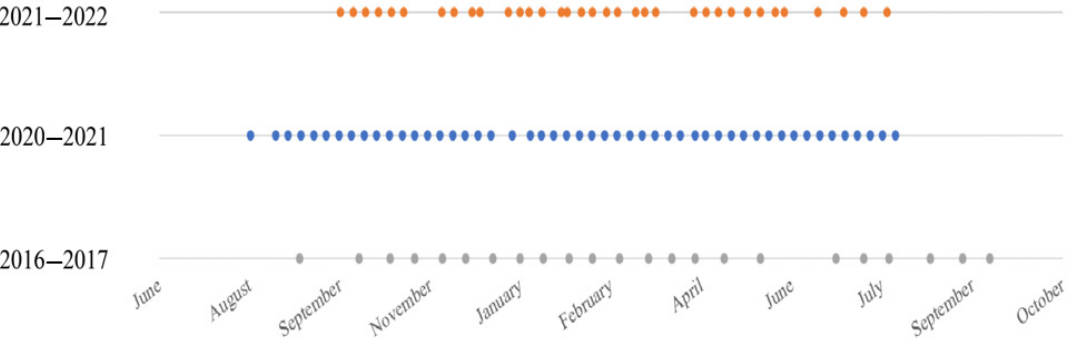
Figure 2. Observation dates on the Don River in 2016 ‐ 2017 (grey points), on the Sochi River in 2020–2021 (blue points), and on the Matsesta River in 2021 ‐ 2022 (orange points). Table 1. The main parameters of the considered rivers and the number of monitoring sessions and hours.